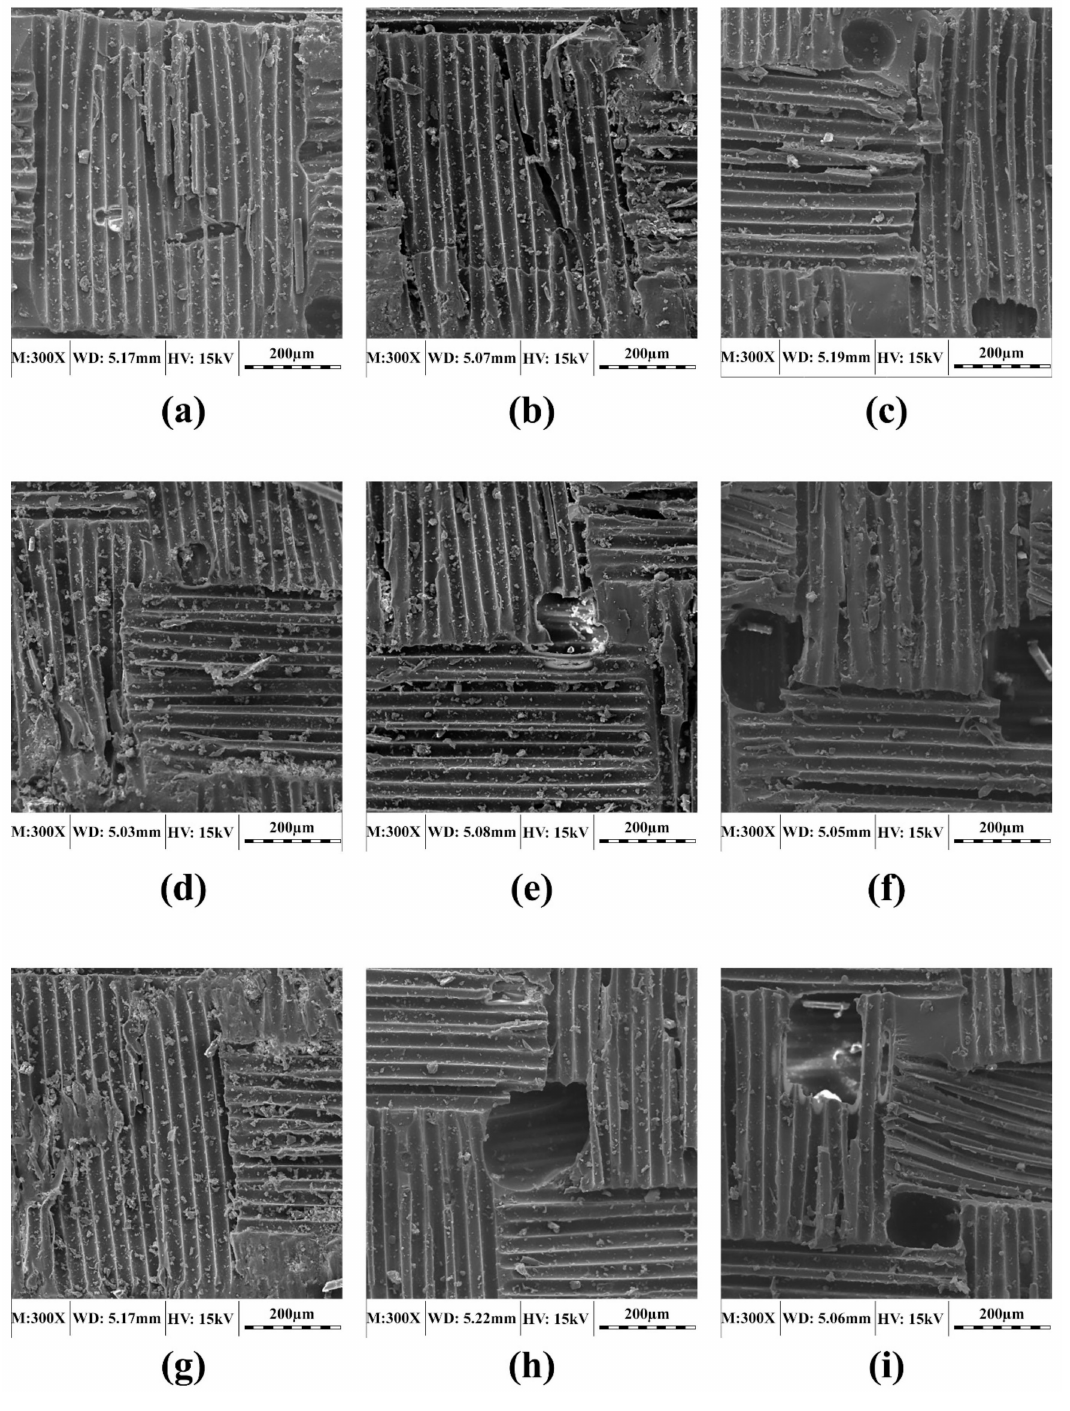
Figure 5. SEM micrographs of selected 2-mm laminates exposed to dry freeze / thaw cycles: ( a ) UL exposed to 750-h cycles, ( b ) UL exposed to 1250-h cycles, ( c ) UL exposed to 2000-h cycles, ( d ) WL exposed to 750-h cycles, ( e ) WL exposed to 1250-h cycles, ( f ) WL exposed to 2000-h cycles, ( g ) RL exposed to 750-h cycles, ( h ) RL exposed to 1250-h cycles and ( i ) RL exposed to 2000-h